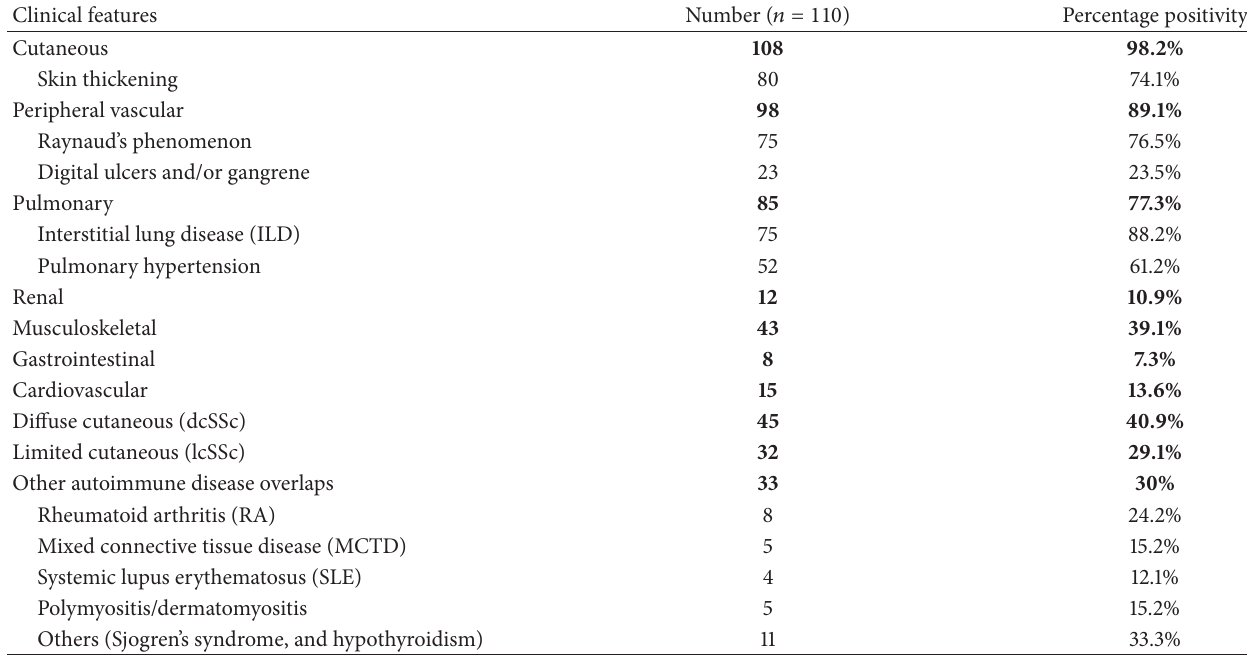
Table 1: Clinical presentation of scleroderma patients studied ( 𝑛 = 110 ).